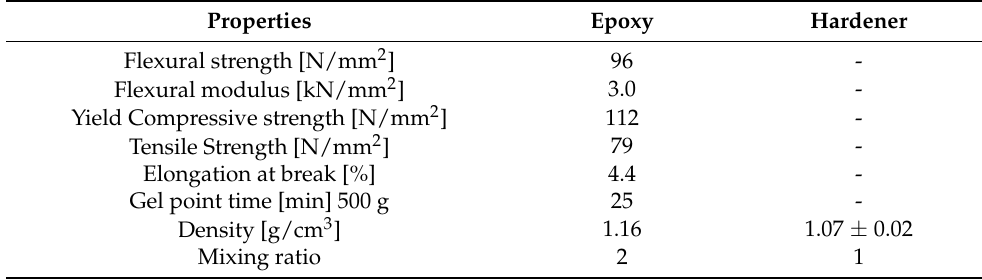
Table 1. Characteristics of epoxy, D.E.R TM 331 TM and hardener, JOINTMINE TM 925-3S TM (MSDS